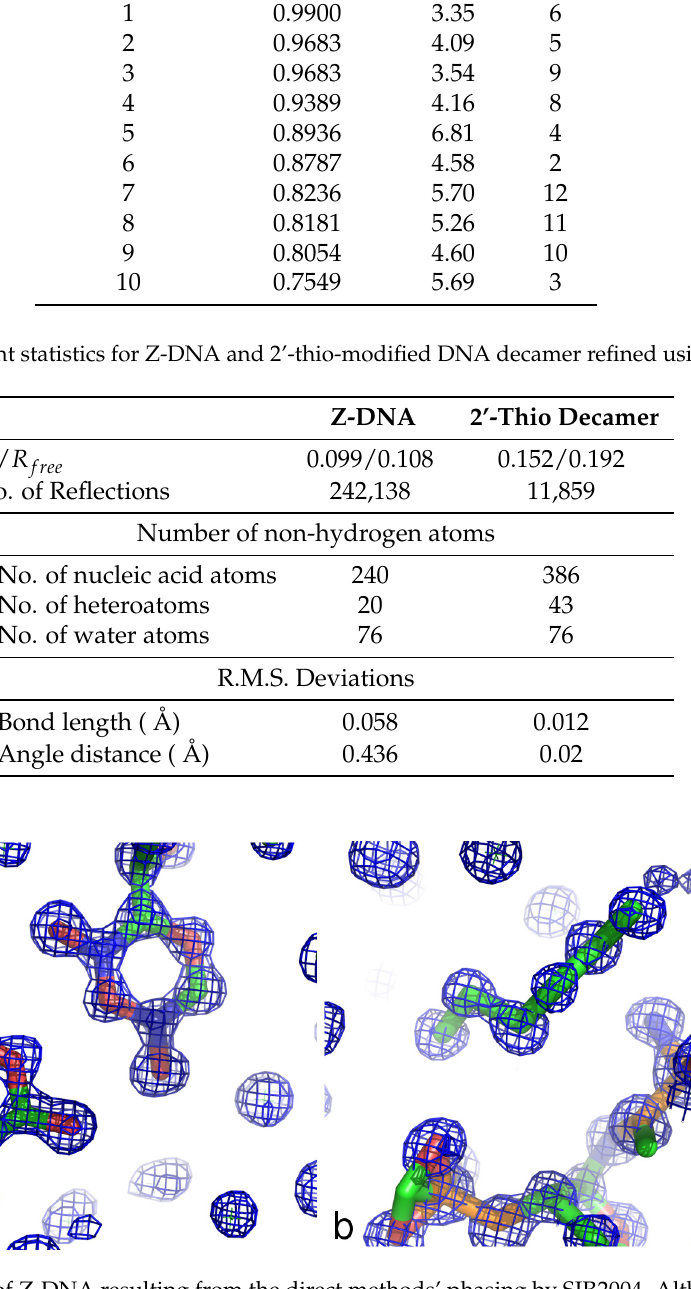
Figure 5. ( a ) Model of Z-DNA resulting from the direct methods’ phasing by SIR2004. Although element assignment is often incorrect, phasing by direct methods was quite good. In the figure, carbon atoms are green; oxygen atoms are red; phosphorus atoms are orange; and nitrogen atoms are blue. ( b ) Direct methods’ phasing using SIR2004 was able to place six atoms of the spermine